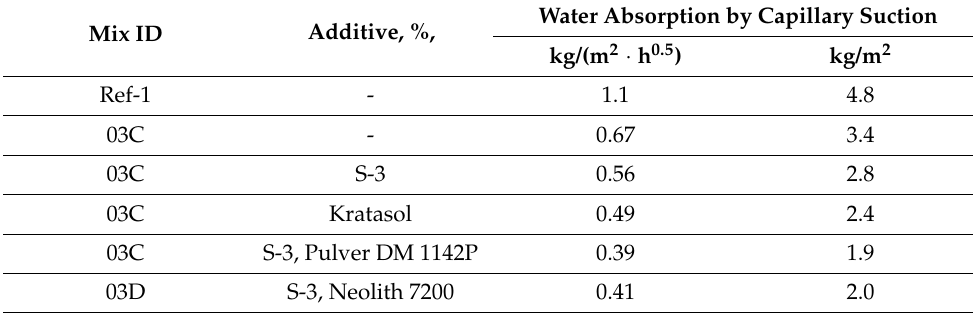
Table 15. Water absorption during capillary suction.